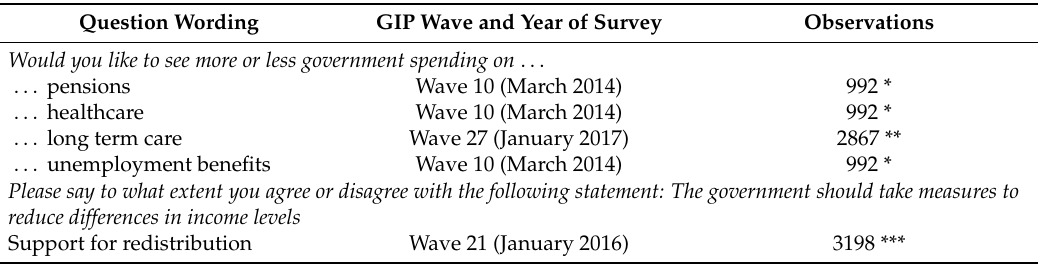
Table 1. Dependent